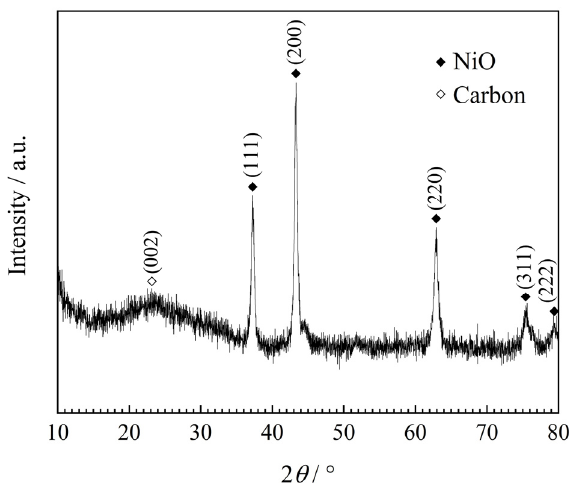
Figure 4. X-ray di ff raction (XRD) pattern of NiO / C aerogel microspheres with a plum-pudding structure. Figure 4. X ‐ ray diffraction (XRD) pattern of NiO/C aerogel microspheres with a plum ‐ pudding structure.